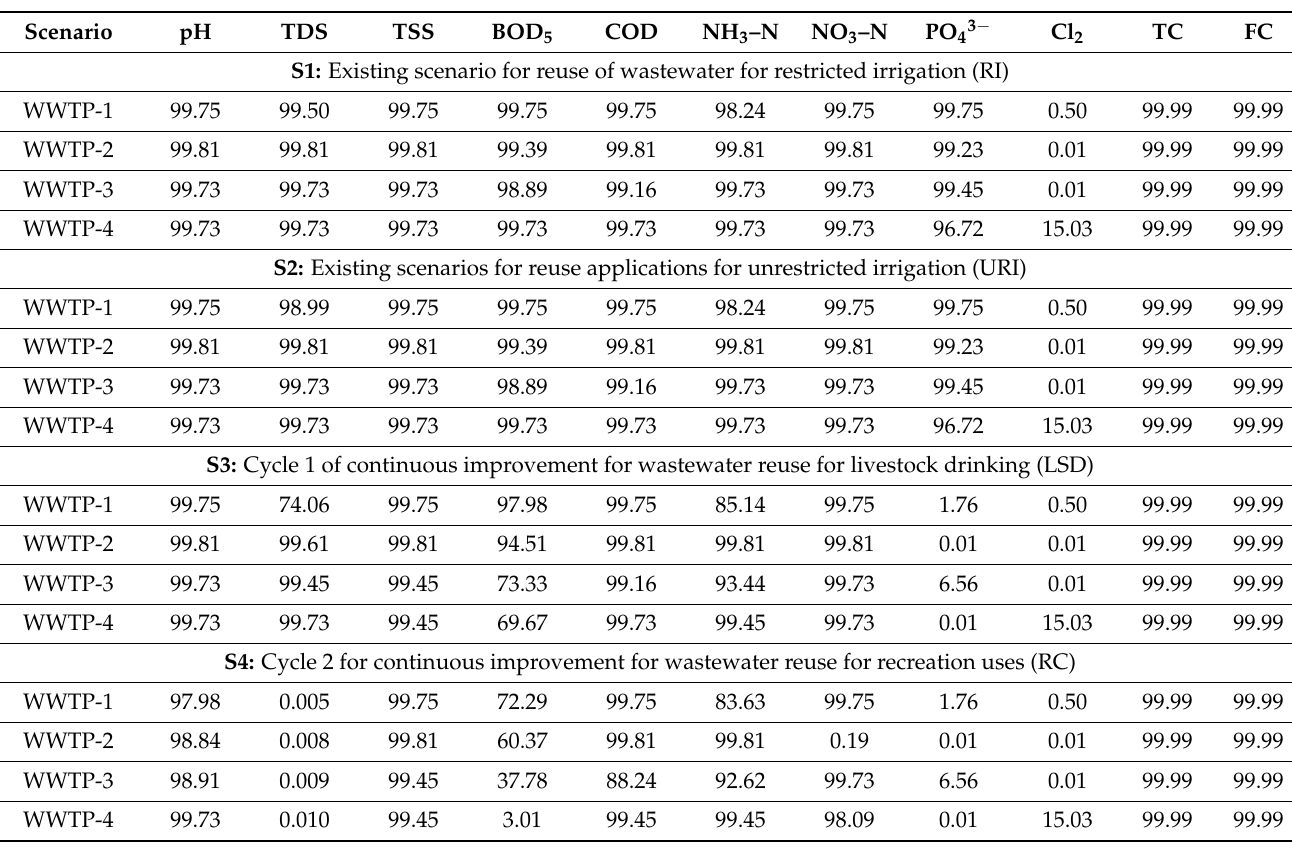
Table 7. Probabilities of meeting the desired effluent standards of the WWT facilities.